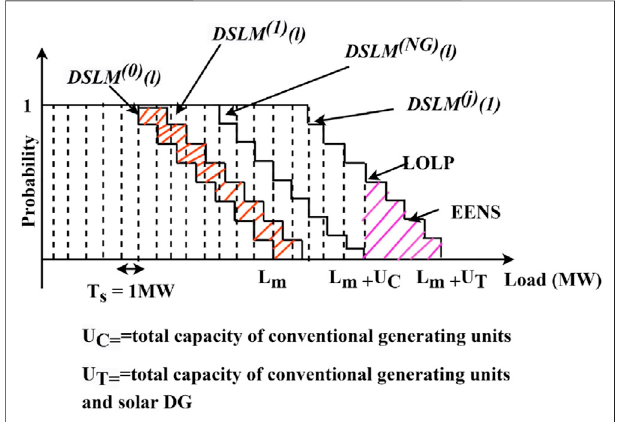
FIGURE6 | DSLM considering outage of all theconventional generators and solar